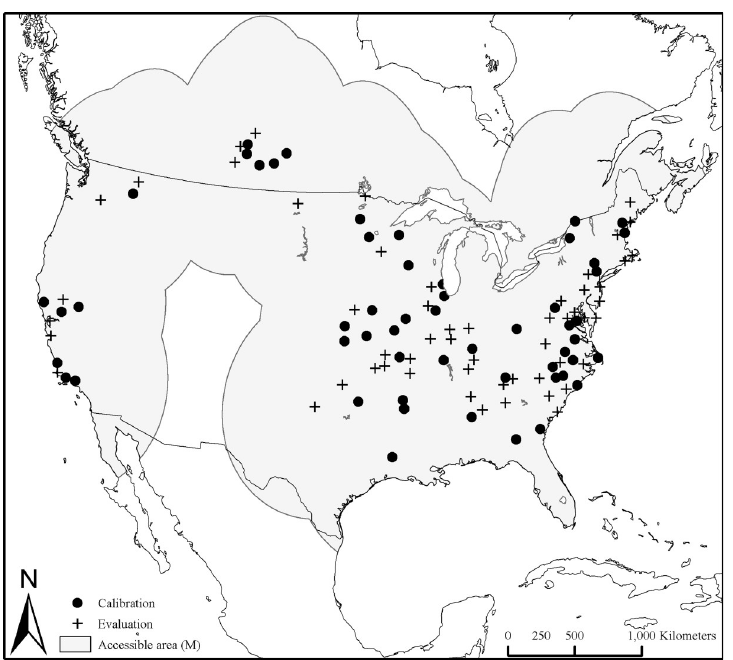
Fig 1. Occurrence locations of Dermacentor variabilis used for calibrating and evaluating ecological niche models, and the accessible area, M used in the study.